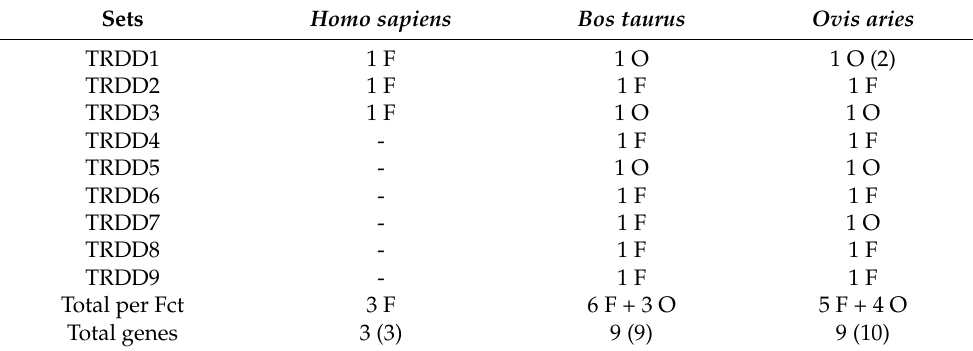
Table 5. IMGT Potential germline repertoires of the TRDD sets in human ( Homo sapiens ), bovine ( Bos taurus ) and sheep ( Ovis aries ). Sets